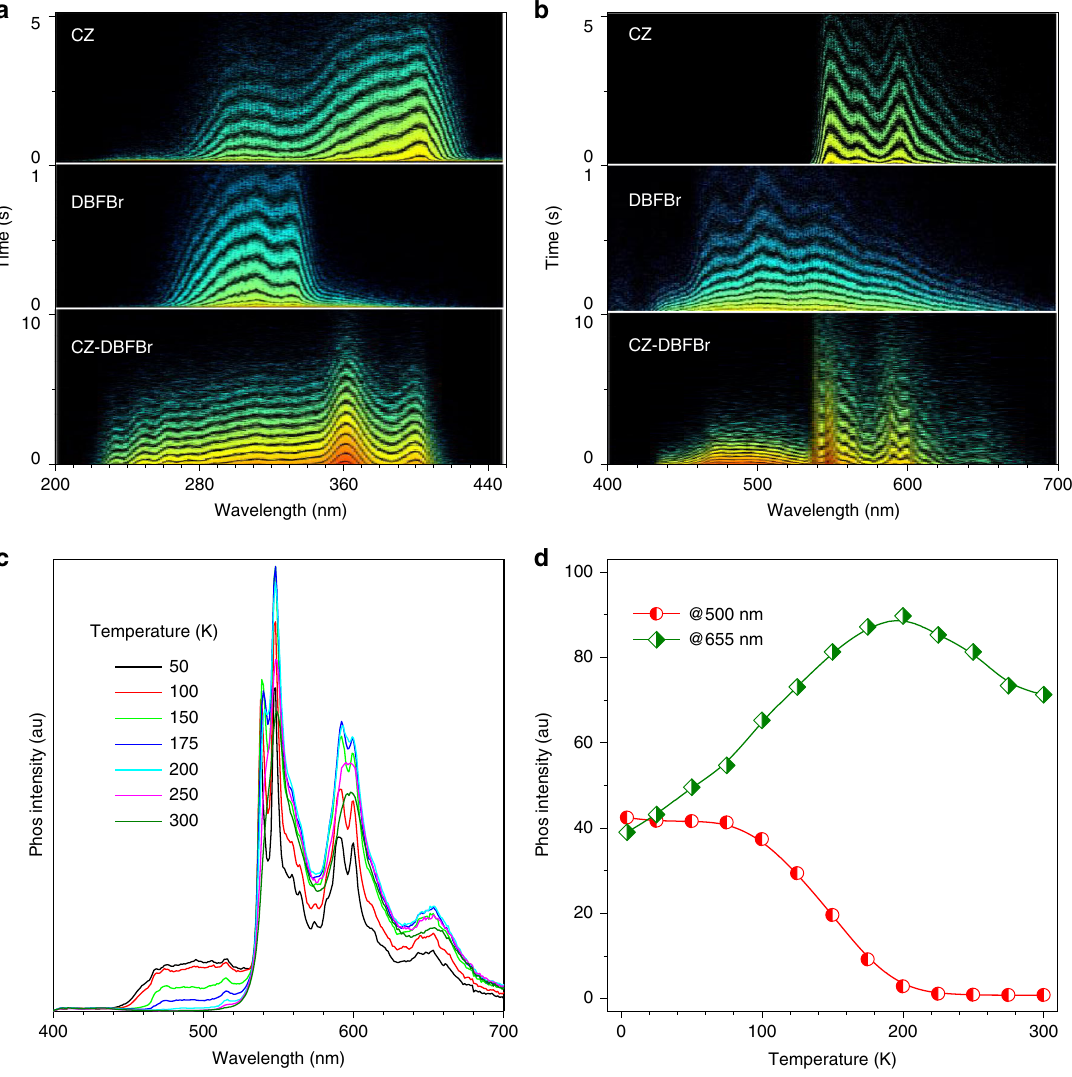
Fig. 6 Time-resolved excitation/emission and temperature-dependent PL spectra. a Time-resolved excitation spectra of CZ, DBFBr, and CZ-DBFBr in the crystalline state at 4 K. b Time-resolved emission spectra of CZ, DBFBr, and CZ-DBFBr in solid state at 4 K. c Temperature-dependent steady-state PL spectra of CZ-DBFBr in solid state from 4 to 300 K. d Temperature-dependent intensity of emission bands at 500 and 655 nm. The excitation of CZ and CZ-DBFBr was 400 nm; while the excitation of DBFBr was 330